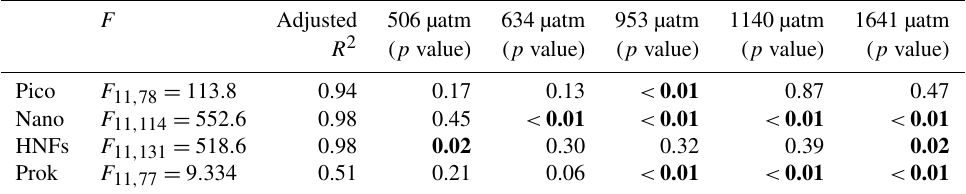
Table 3. ANOVA results comparing trends in steady-state logarithmic growth for each f CO 2 treatment over time against the control.